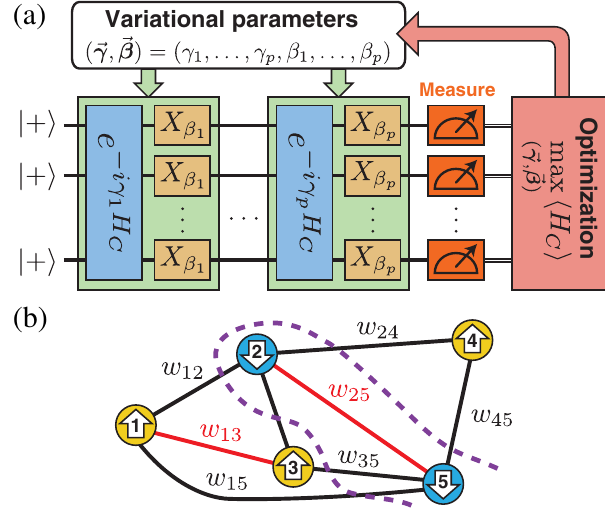
FIG. 1. (a) Schematic of a p -level quantum approximation optimization algorithm [2]. A quantum circuit takes input jþi ⊗ n and alternately applies e − i γ i H C and X β ¼ e − i β i σ x , and the final i state is measured to obtain the expectation value with respect to the objective function H C . This result is fed to a (classical) ⃗ β optimizer to find the best parameters ð ⃗ γ ; Þ that maximizes h H C i . (b) An example of a MaxCut problem on a five-vertex graph, where one seeks an assignment of spin variables on the vertices such that the sum of edge weights between antialigned spins is maximized (black